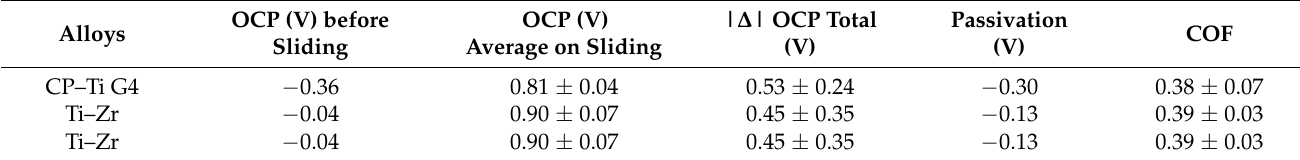
Table 4. Electrochemical and tribological parameters, obtained from the potentiodynamic polarization curves of the alloys studied in